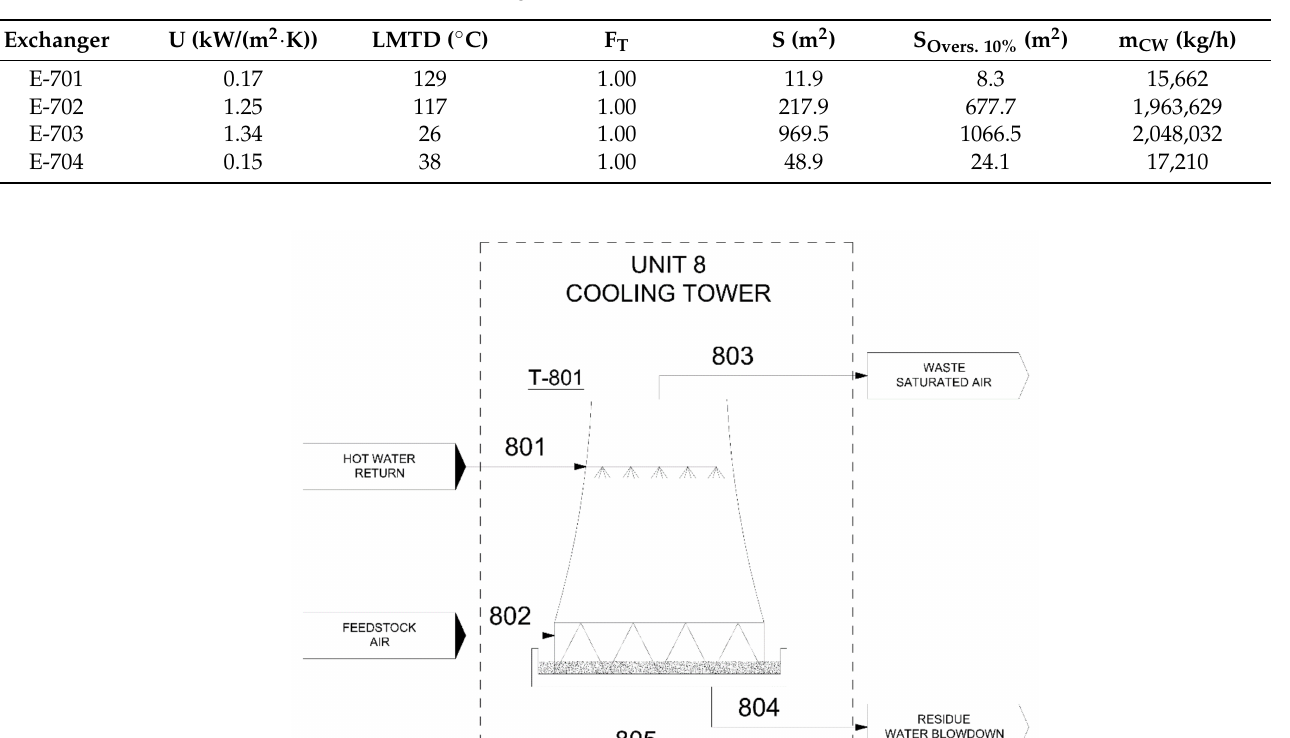
Table 11. Design of condensers for Unit 7 (cont.).